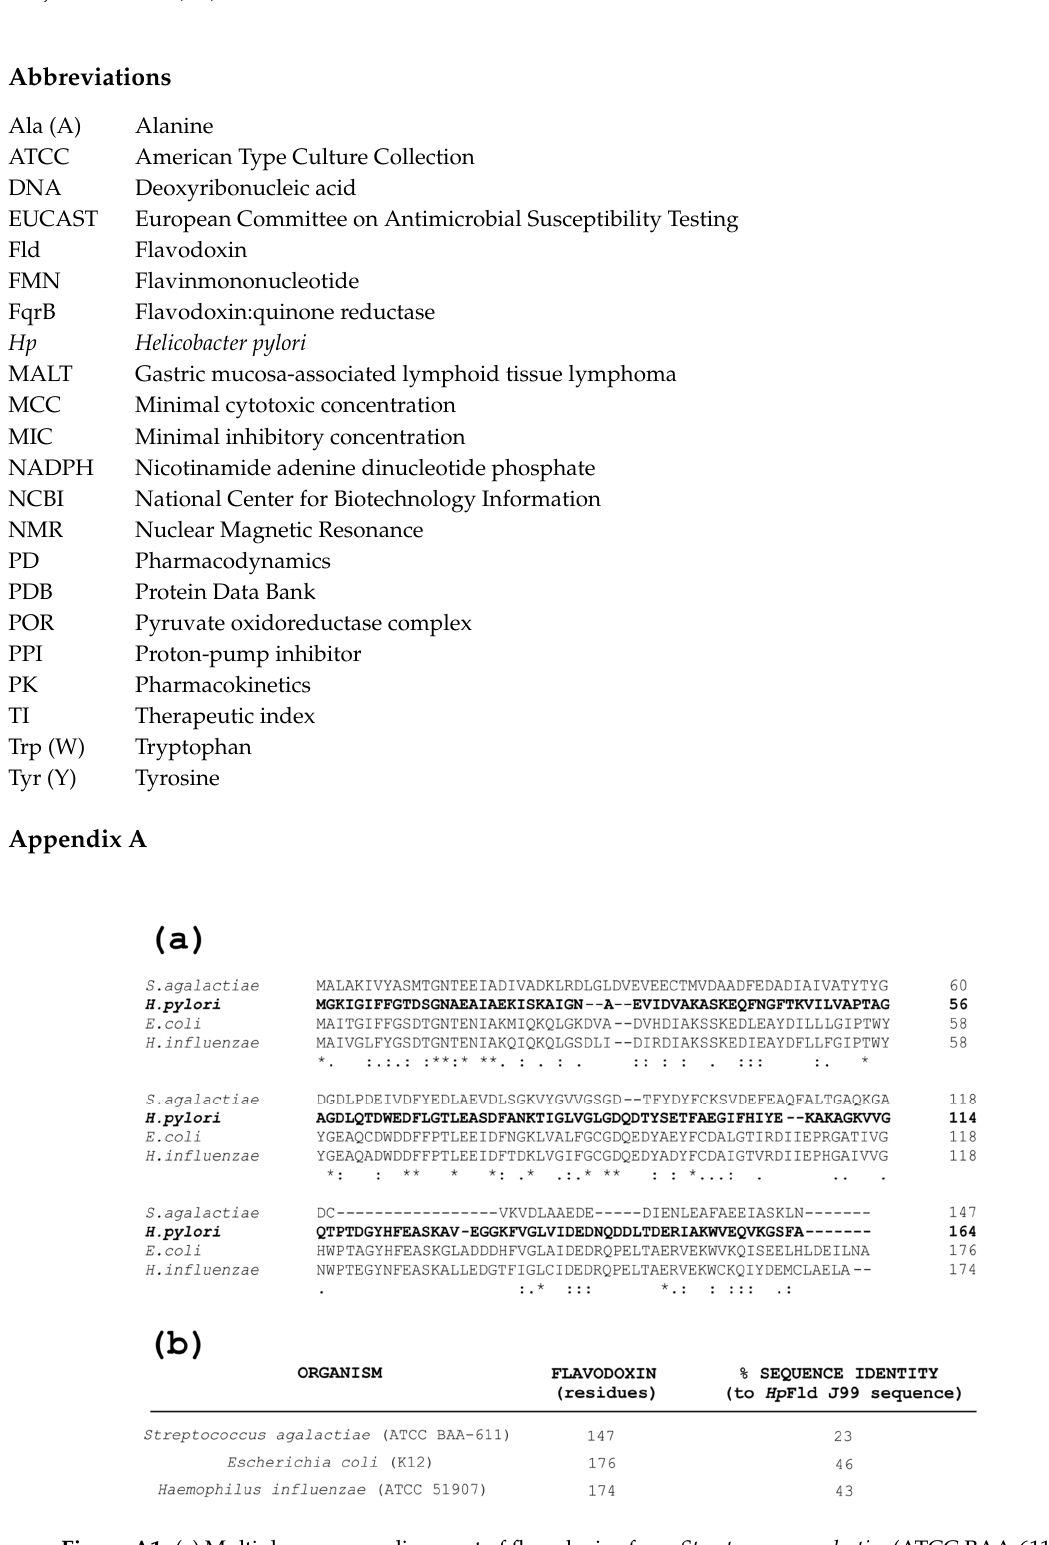
Figure A1. ( a ) Multiple sequence alignment of flavodoxins from Streptococcus agalactiae (ATCC BAA-611), Hp (strain J99), Escherichia coli (strain K12), and Haemophilus influenzae (strain ATCC 51907). It has been performed with Clustal Omega [194]. Asterisks (*) indicate positions with a single residue; colons (:) indicate conservation between groups of strongly similar properties; dots (.) indicate conservation between groups of weakly similar properties. ( b ) Sequence identity between Hp (strain J99) flavodoxin and that from Streptococcus agalactiae (ATCC BAA-611), Escherichia coli (strain K12), and Haemophilus influenzae (strain ATCC 51907). It has been calculated with Clustal Omega [194].